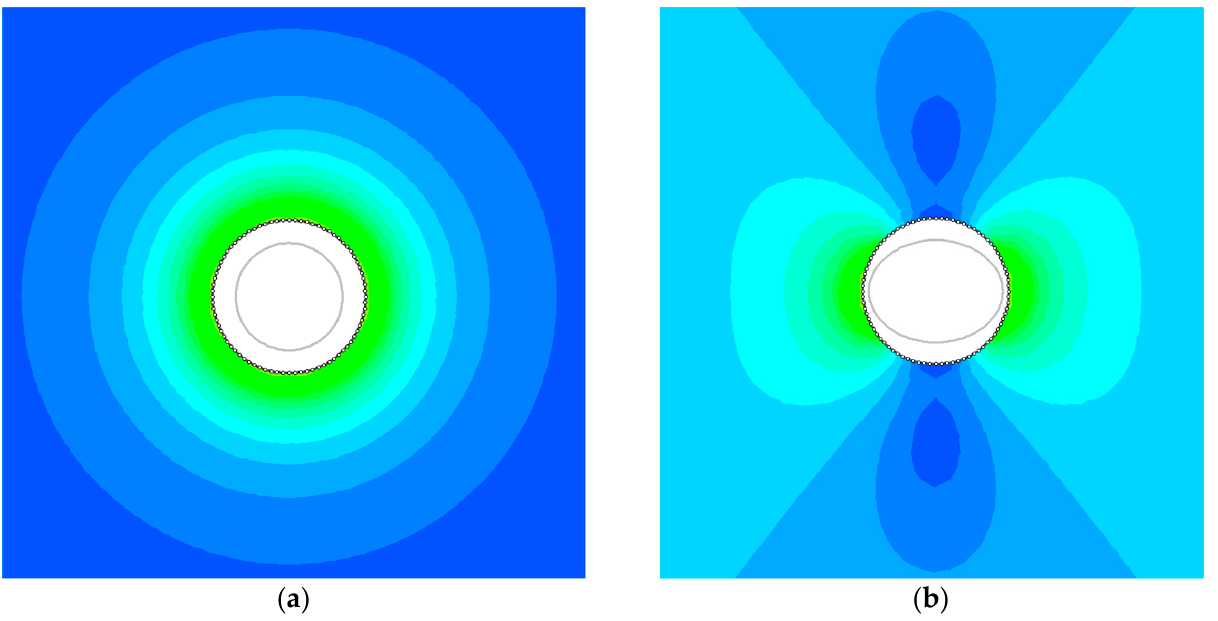
Figure 4. Stress distribution and tunnel deformation for ( a ) hydrostatic loading, and ( b ) non-hydrostatic loading.